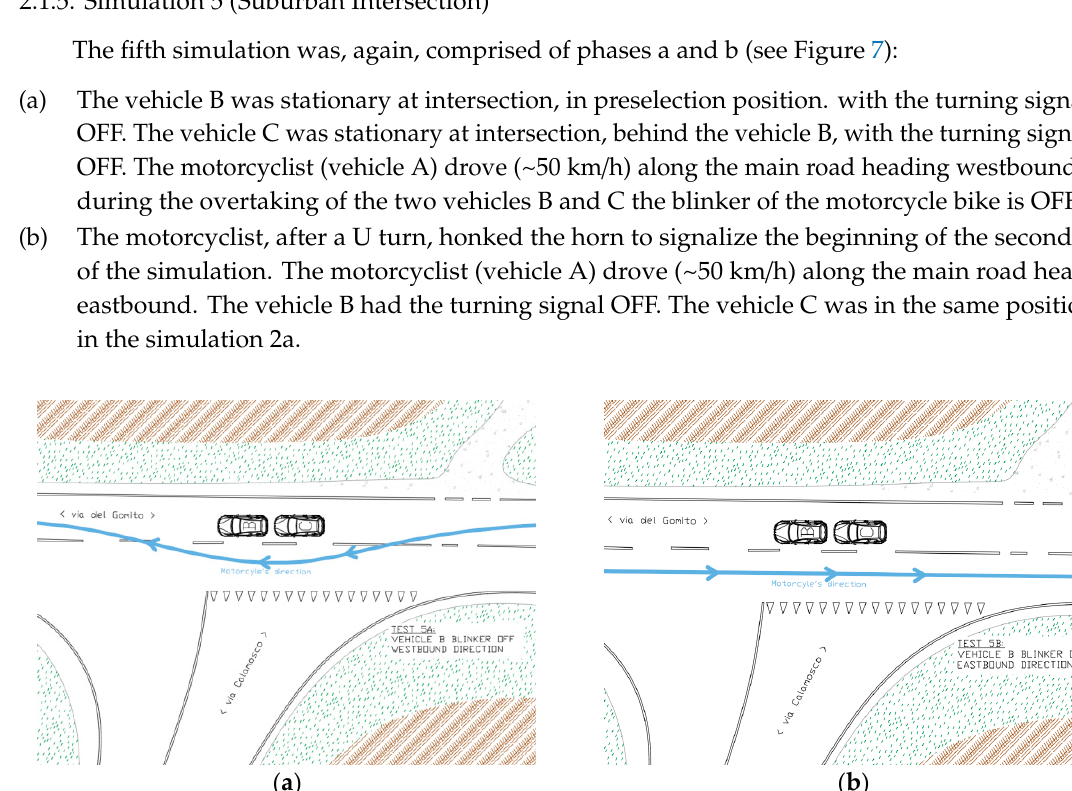
Figure 6. Simulation 4 ( a ) overtaking, and 4( b ) going through, schemes.